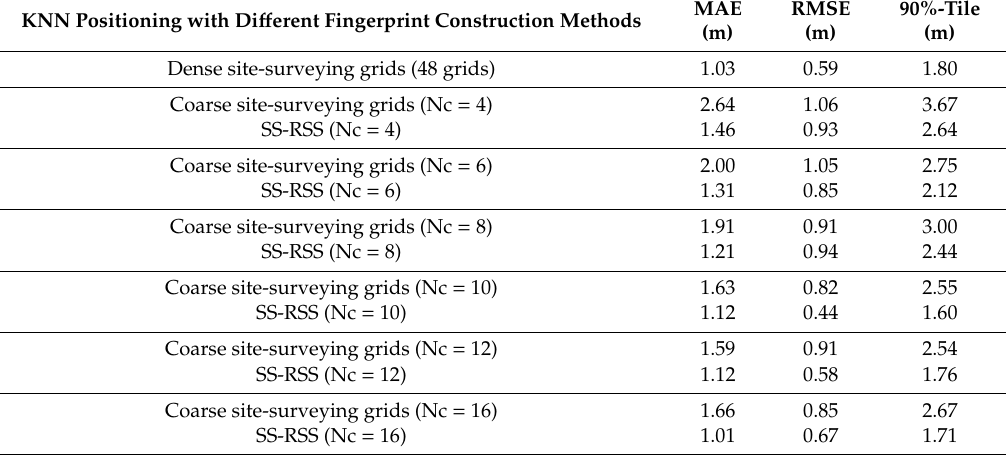
Table 4. KNN positioning accuracy of different fingerprint construction methods.